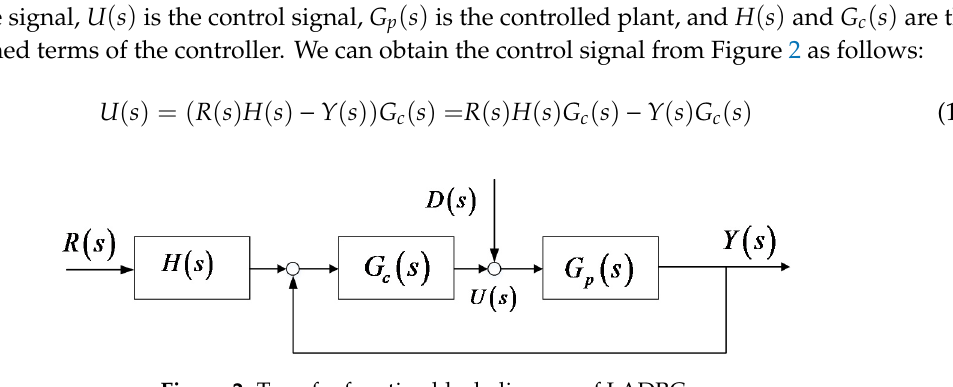
Figure 2. Transfer function block diagram of LADRC.